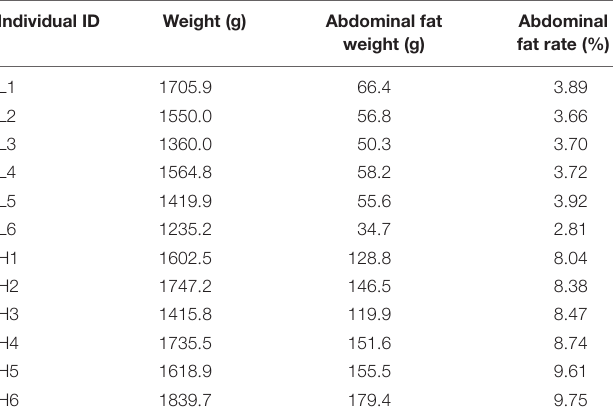
TABLE 1 | Abdominal fat rate of 12 Sanhuang